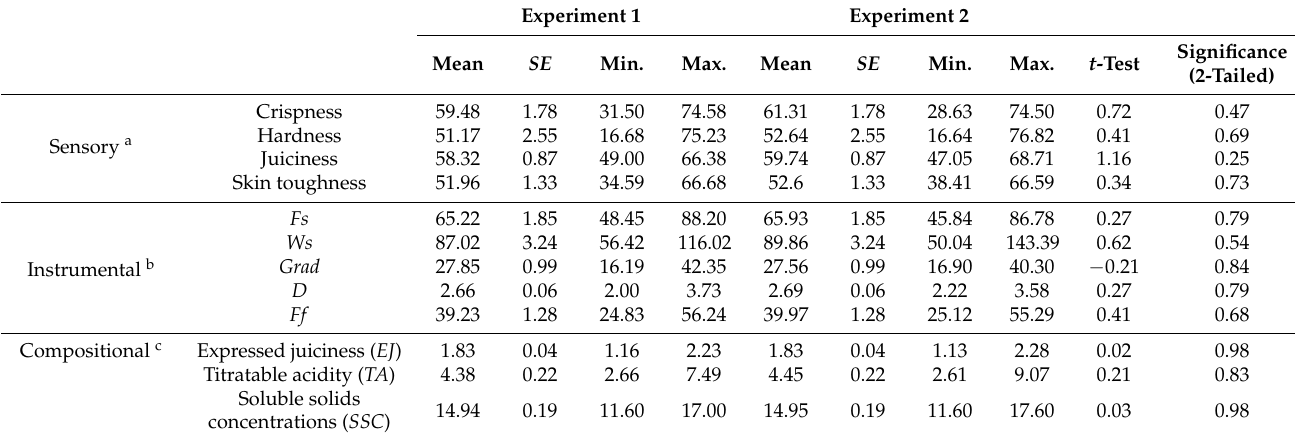
Table 2. Means, standard errors ( SE ), minimum (Min.), maximum (Max.) and t -test results of the comparison of sensory, instrumental, and compositional data obtained in Experiment #1 and Experiment #2 ( n = 72, df =